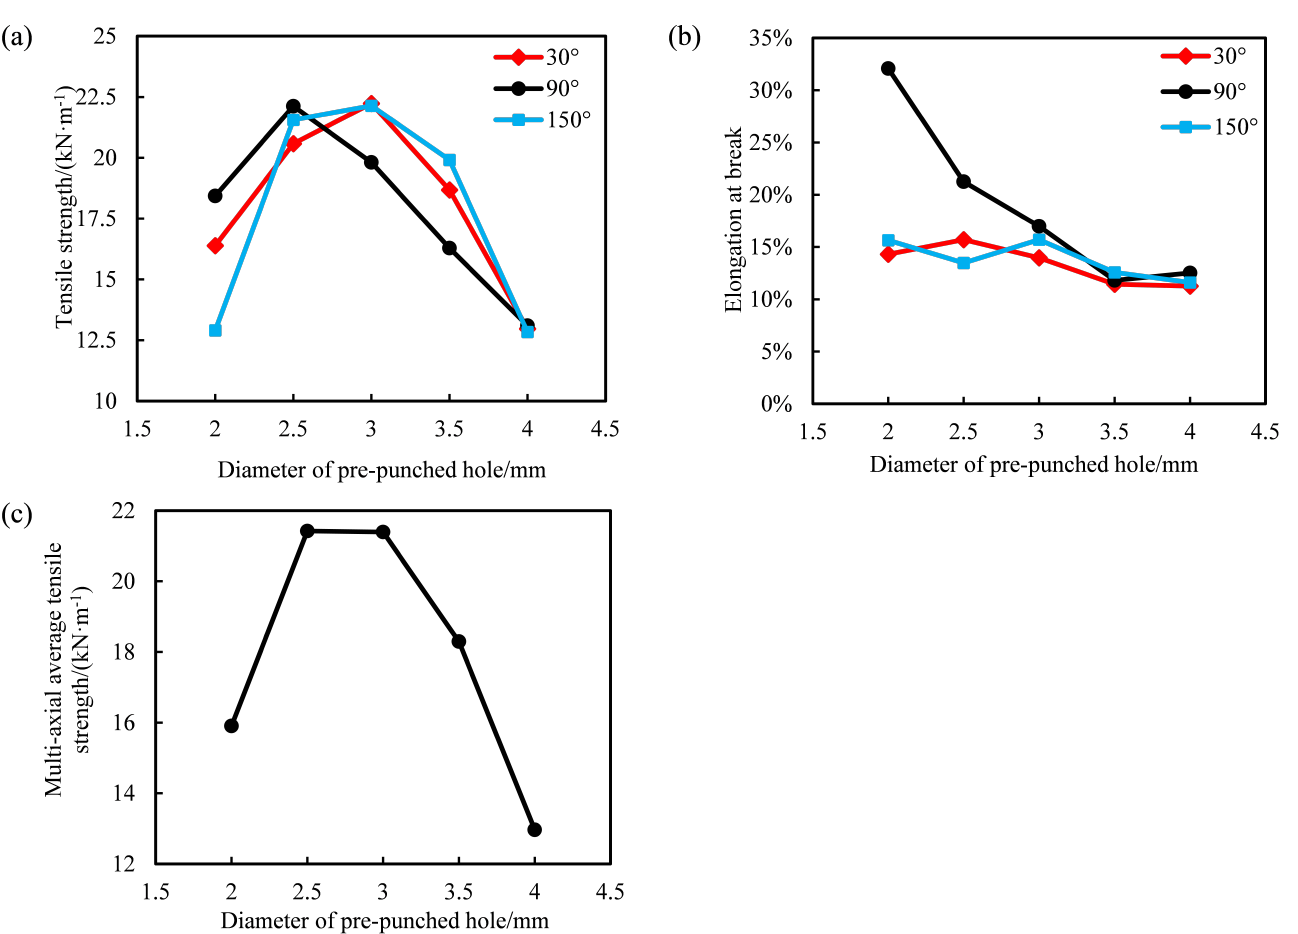
Figure 8. The relationship between the mechanical properties and the diameter of the pre-punched holes of triaxial geogrid. ( a ) Tensile strength, ( b ) elongation at break, ( c ) multi-axial average ten- sile